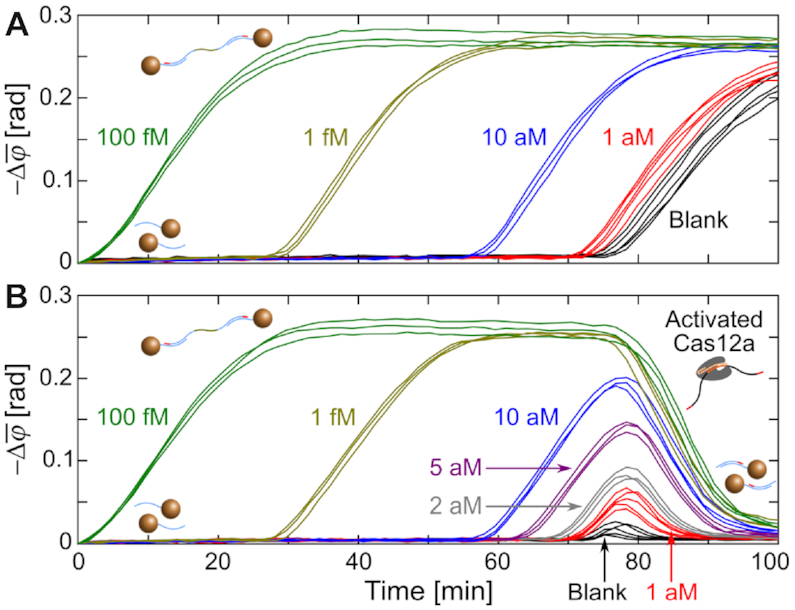
Real-time changes of \documentclass[12pt]{minimal}
\usepackage{amsmath}
\usepackage{wasysym}
\usepackage{amsfonts}
\usepackage{amssymb}
\usepackage{amsbsy}
\usepackage{upgreek}
\usepackage{mathrsfs}
\setlength{\oddsidemargin}{-69pt}
\begin{document}
}{}$\bar{\varphi }$\end{document} (1–10 Hz) for the indicated target concentrations amplified by PG-RCA (A) without and (B) with CIRI. Independent replicates (n = 5 for 1 aM targets and blank controls, n = 3 for other target concentrations) are plotted in the same color. Black curves in Figures 3A and 4A are based on the same data.